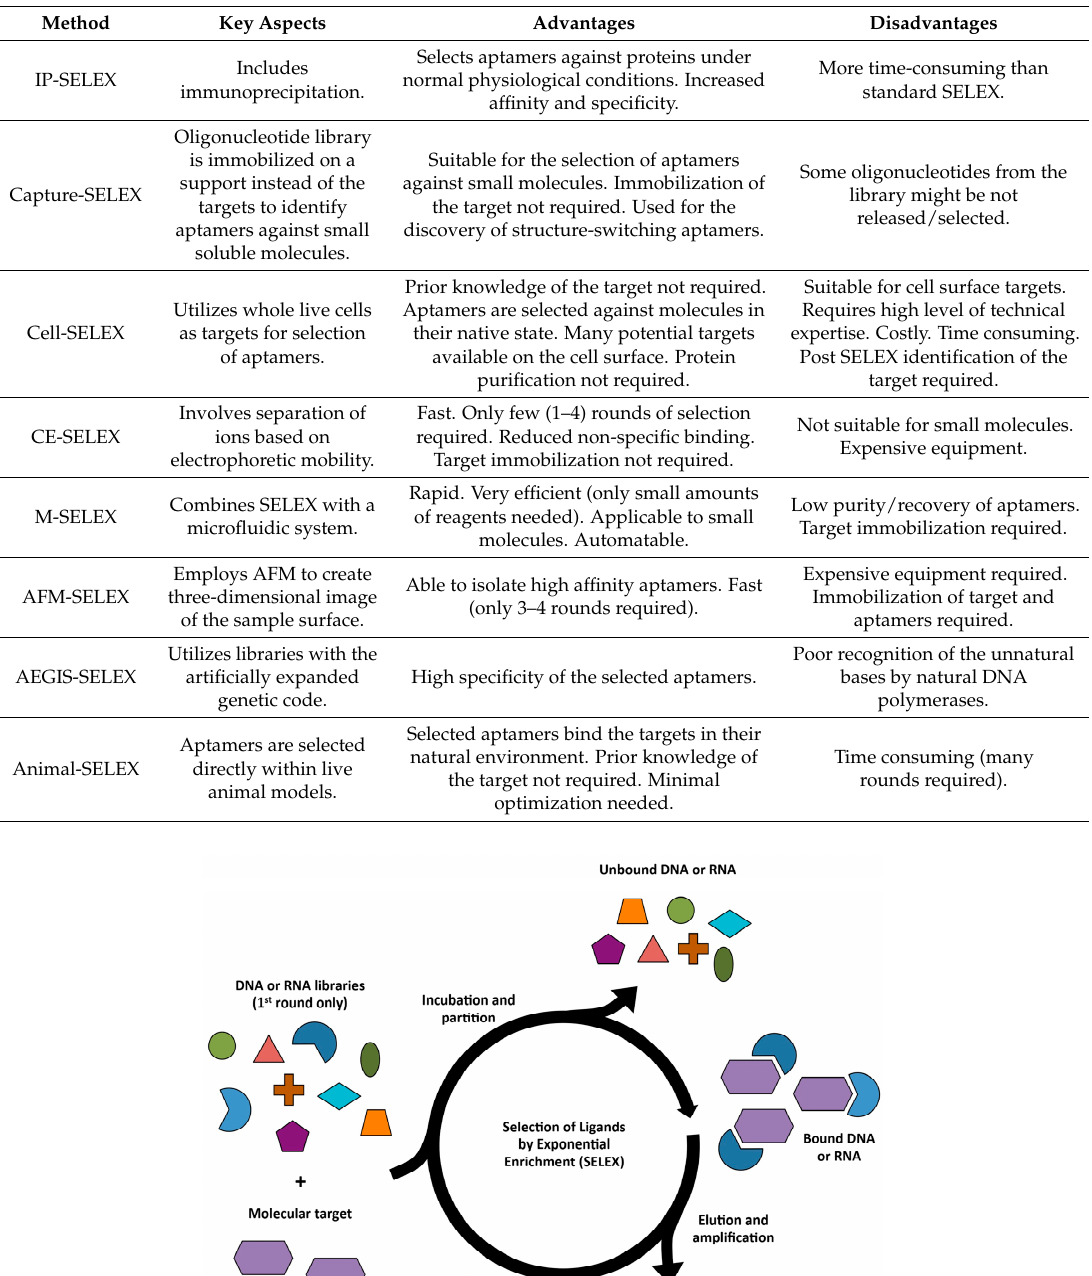
Table 2. Key aspects, advantages, and disadvantages of the currently used SELEX methods.